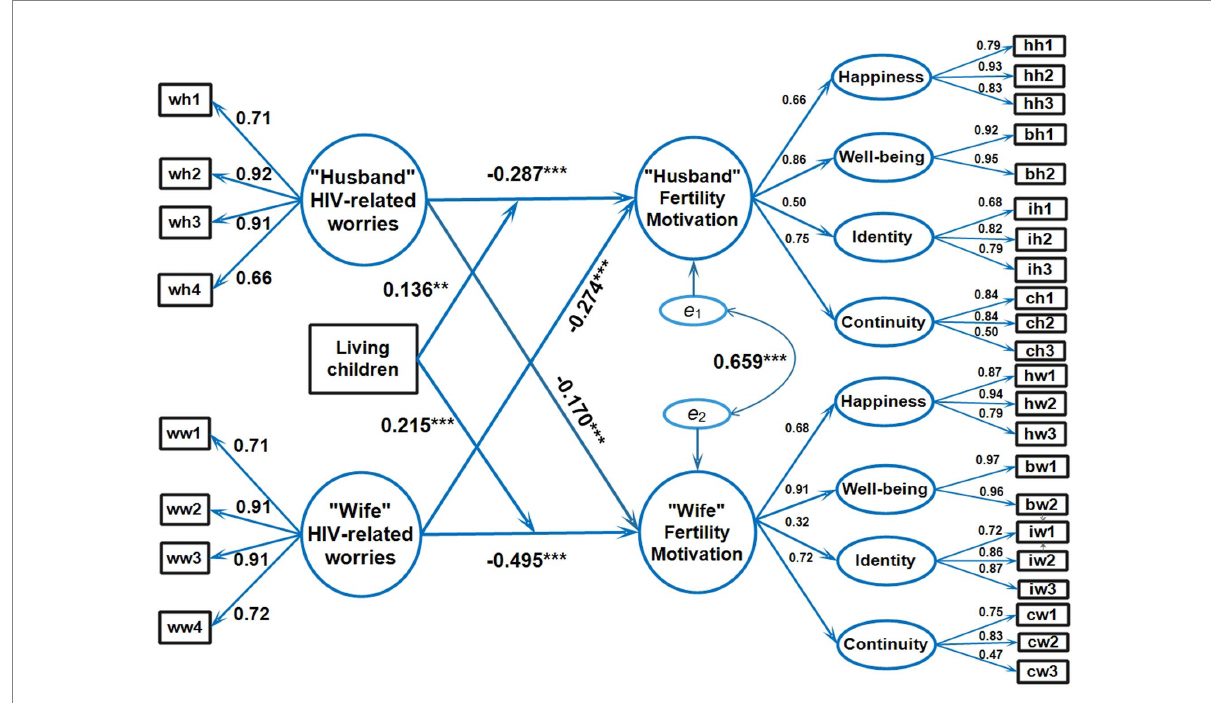
FIGURE 2 Actor-partner interdependence moderation model of husband-wife dynamics ( N = 322). wh1/ww1, wh2/ww2, wh3/ww3, wh4/ww4, Worries indicators; hh1/hw1, hh2/hw2, hh3/hw3, Happiness indicators; bh1/bw1, bh2.bw2, Well-being indicators; ih1/iw1, ih2/iw2, ih3/iw3, Identity indicators; ch1/cw1, ch2/cw2, ch3/cw3, Continuity indicators. The individual definitions of each abbreviation were explained in Supplementary Tables 1,